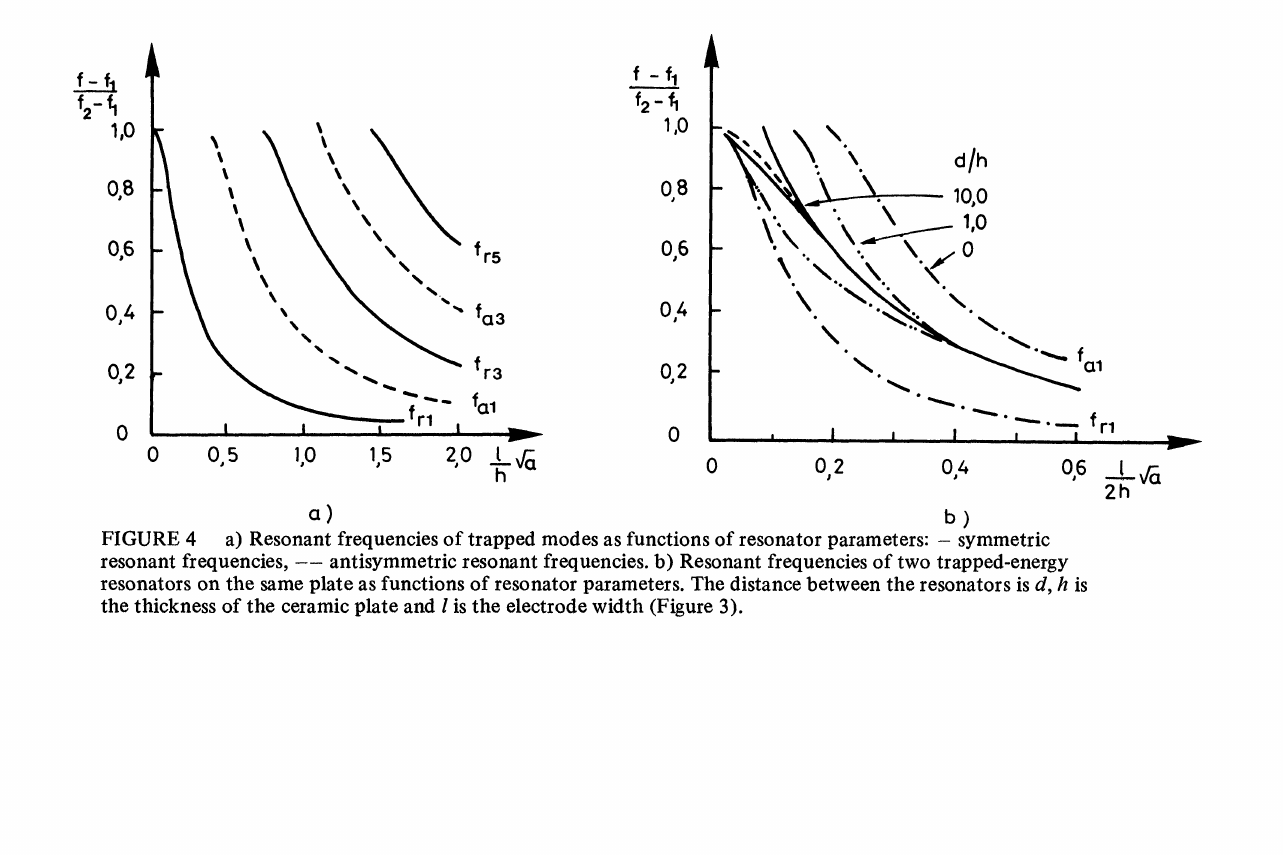
Resonances for wide electrodes. I"1 is the cutoff frequency in the electroded region and f2 is the cutoff frequency in the unelectroded region, fr: to frs are the resonant frequencies.